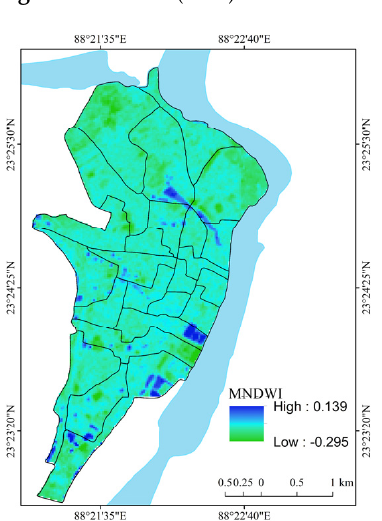
Figure 37. MNDWI Figure 37. MNDWI (2015).